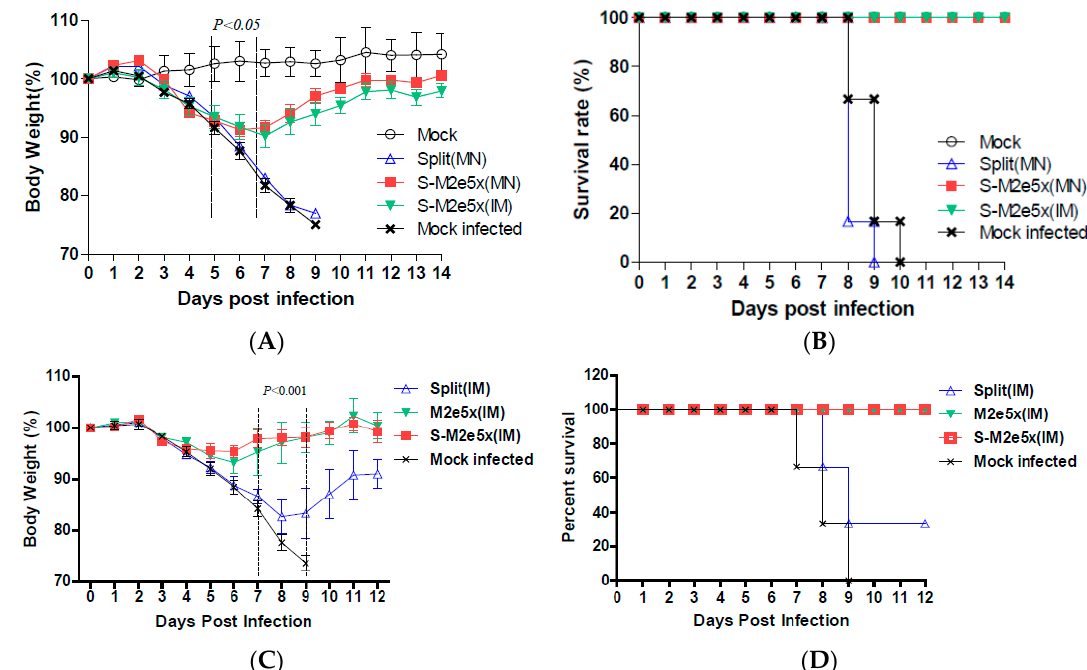
Figure 5. Improved efficacy of cross protection by supplemented S-M2e5x (MN, IM) and M2e5x VLP vaccine. Groups of mice ( N = 6 ) that were immunized on the skin via MN (Split MN, S-M2e5x MN) or IM injection (S-M2e5x IM) were intranasally challenged with a lethal dose (5 × LD 50 ) of influenza viruses, A/Philippines/2/82 (H3N2), 6 weeks after boost vaccination. ( A ) Average body weight changes after challenge with A/Philippines (H3N2). ( B ) Survival rates after challenge with A/Philippines (H3N2). Body weight and survival rates were monitored for 14 days. ( C – D ) In an independent set of experiments to test M2e5x VLP alone and supplemented S-M2e5x vaccines in comparison with split vaccine, groups of mice ( N = 6 ) that were IM immunized with M2e5x VLP (2.5 μ g), Split (0.3 HA μ g), or S-M2e5x [Split (0.3 HA μ g) + M2e5x VLP (2.5 μ g)], and intranasally challenged with a lethal dose (3 × LD 50 ) of A/Philippines/2/82 (H3N2) virus at 6 weeks after boost. ( C ) Average body weight changes. ( D ) Survival rates. One-way ANOVA and Tukey’s post-multiple comparison test were performed. P value indicates a significant difference among the S-M2e5x (MN, IM) or M2e5x (IM) and split MN or IM groups. Data represent mean ± SEM.